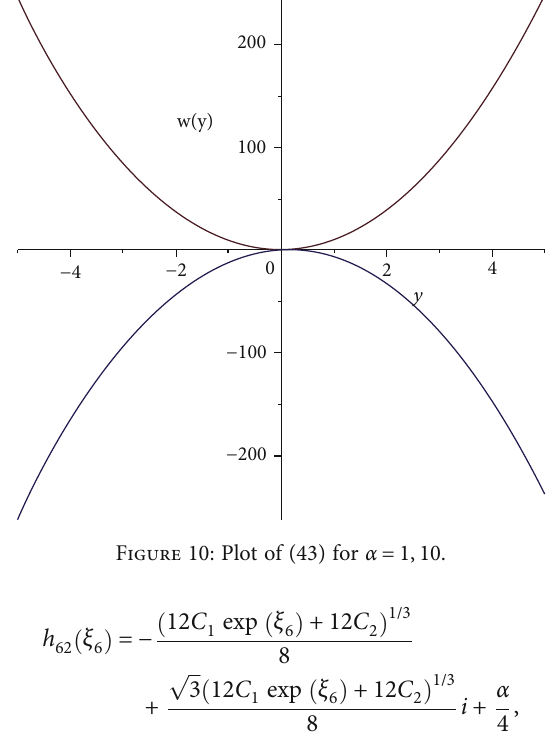
Figure 9: 3D plot of (39) for α = 1 .